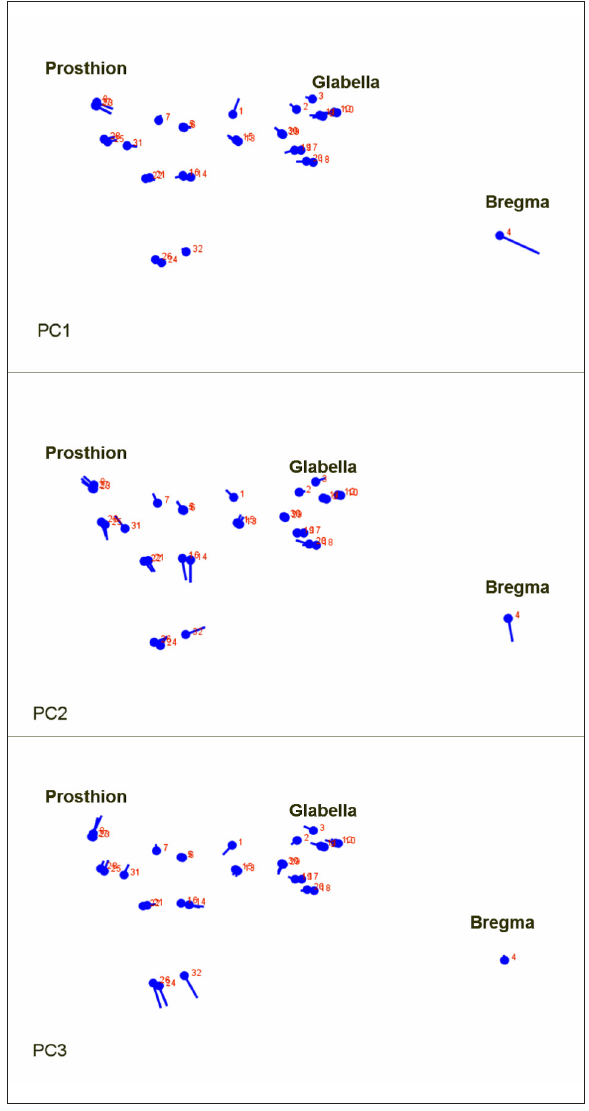
Figure 4: Visualisations of shape change for principal component axes 1–3. Axes correspond to Figure